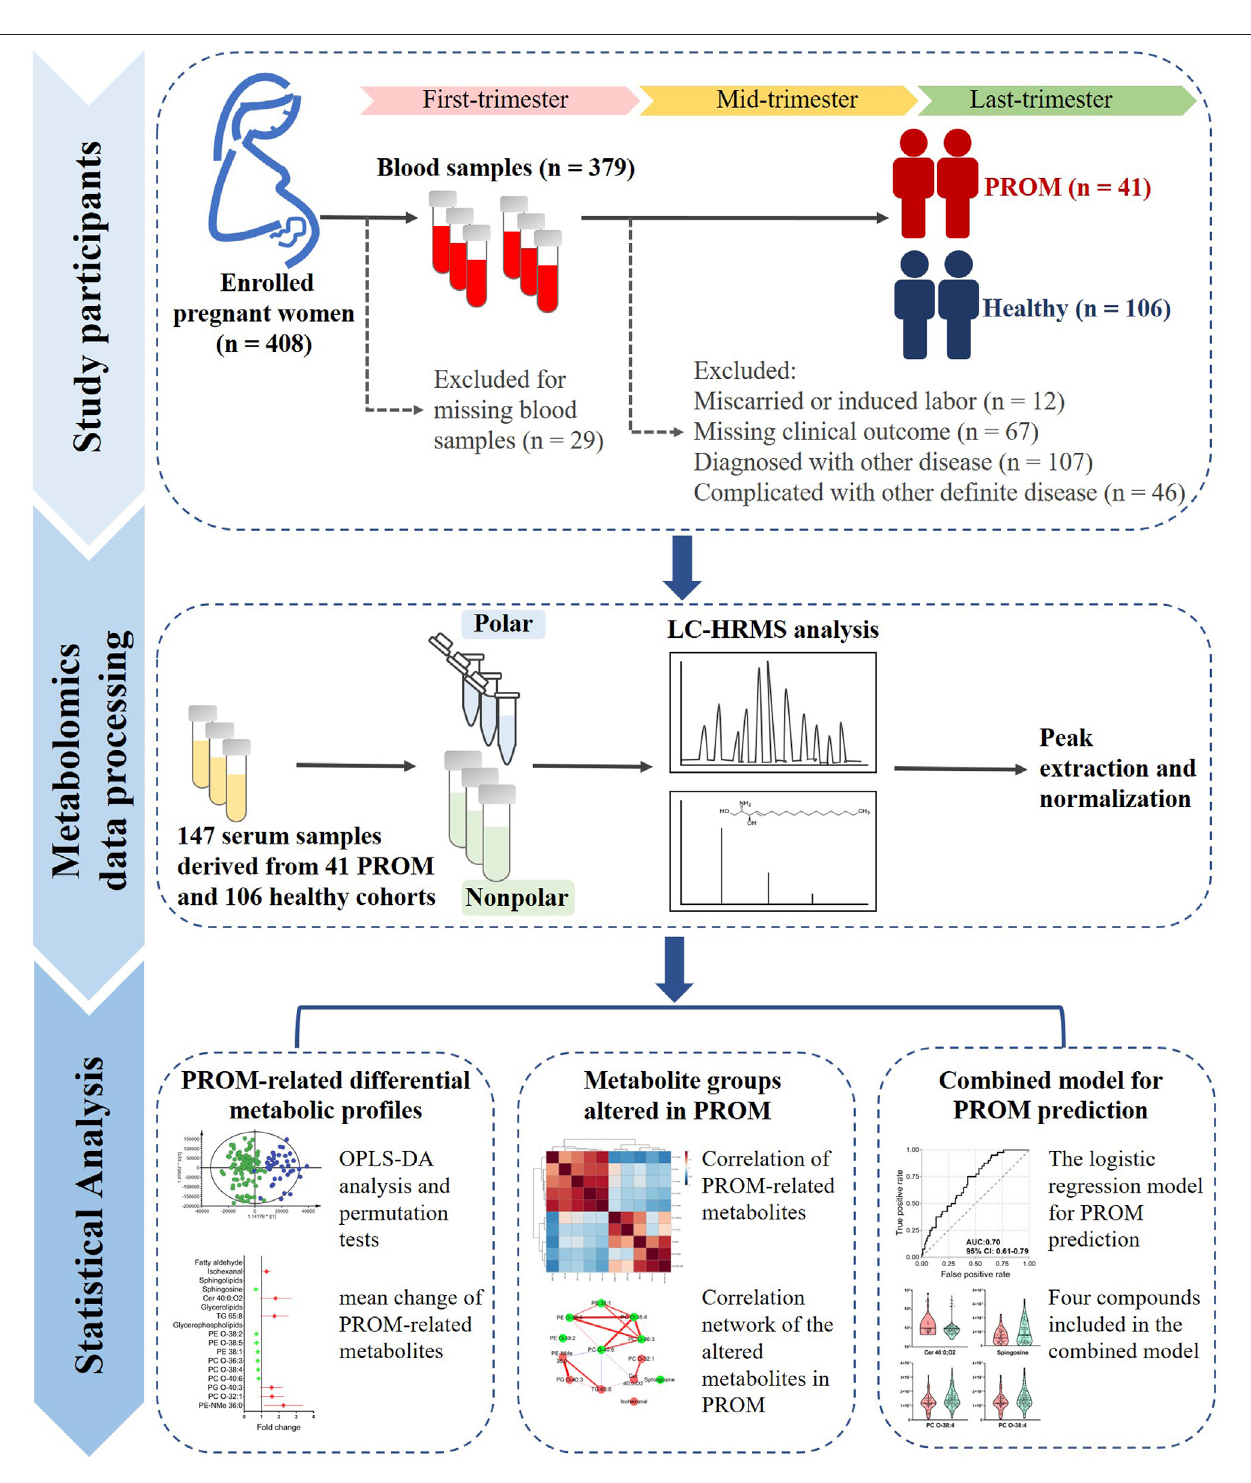
FIGURE1| Thestudydesignofmetabolicpro fi lingofserumsamplesfromwomenwithPROMinthe fi rsttrimester.Therewerethreesteps:1)408pregnantwomen wereenrolled,and379serumsampleswerecollectedinthe fi rsttrimester.Ofthesewomen,196wereexcludedformiscarriageorinducedlabor( n =12),missingclinical outcome data ( n = 67), diagnosis of another disease ( n = 107) or PROM complicated with other de fi nite diseases ( n = 46). Finally, 41 samples from women with PROM and 106fromhealthycontrolswere included. 2)Metabolomics data processing using untargeted metabolomics wasbasedon HPLC – HRMS,and the peaks were extracted and normalized; the features were identi fi ed according to compound databases. 3) The statistical analysis included identi fi cation of PROM-related differential metabolites and changes in metabolite groups in PROM in the fi rst trimester; the fi nal combined model included four potential biomarkers for predicting PROM.